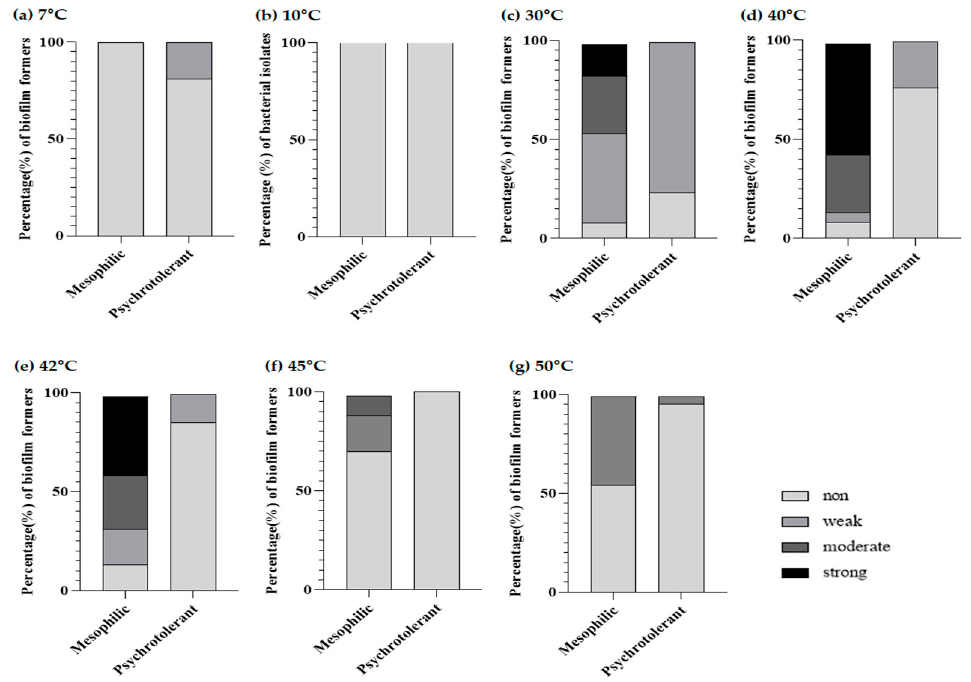
Figure 2. Biofilm phenotype (%) of mesophilic and psychrotolerant B. cereus isolates from chilled tofu at 7 °C ( a ), 10 °C ( b ), 30 °C ( c ), 40 °C ( d ), 42 °C ( e ), 45 °C ( f ), and 50 °C ( g ).